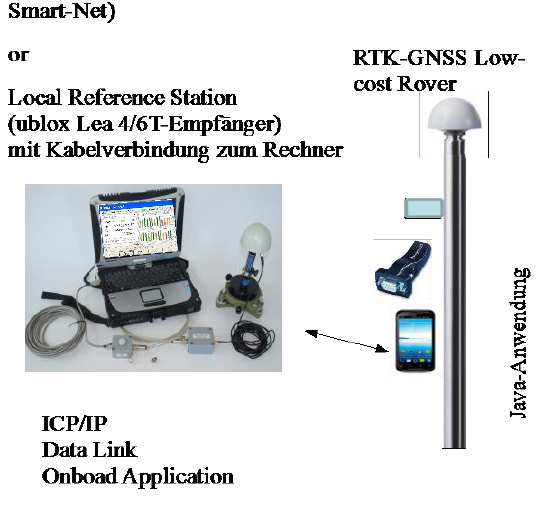
Figure 4, L1 RTK GNSS Rover System, e.g. Ground Control Point